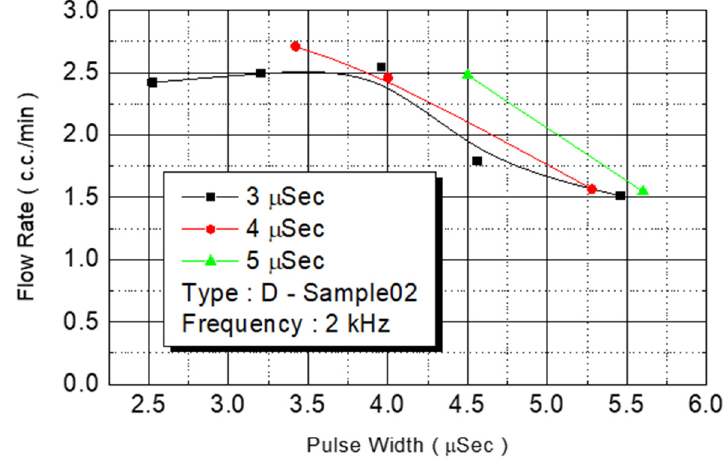
Figure 15. D Type-02 flow test.